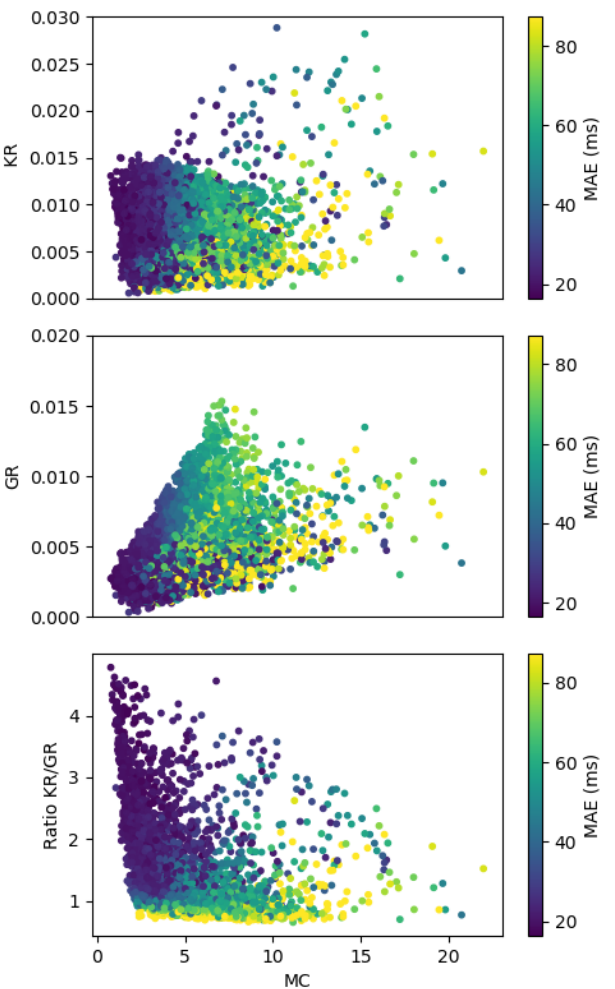
Figure A1. Relationship between the CHARC metrics and the mean absolute error for all events. Exploration was done on the CIRRIS database with timeseries of 3 conditions: normal, right toe out and right side trunk leaning. Five different walking speeds and both subjects were selected (30